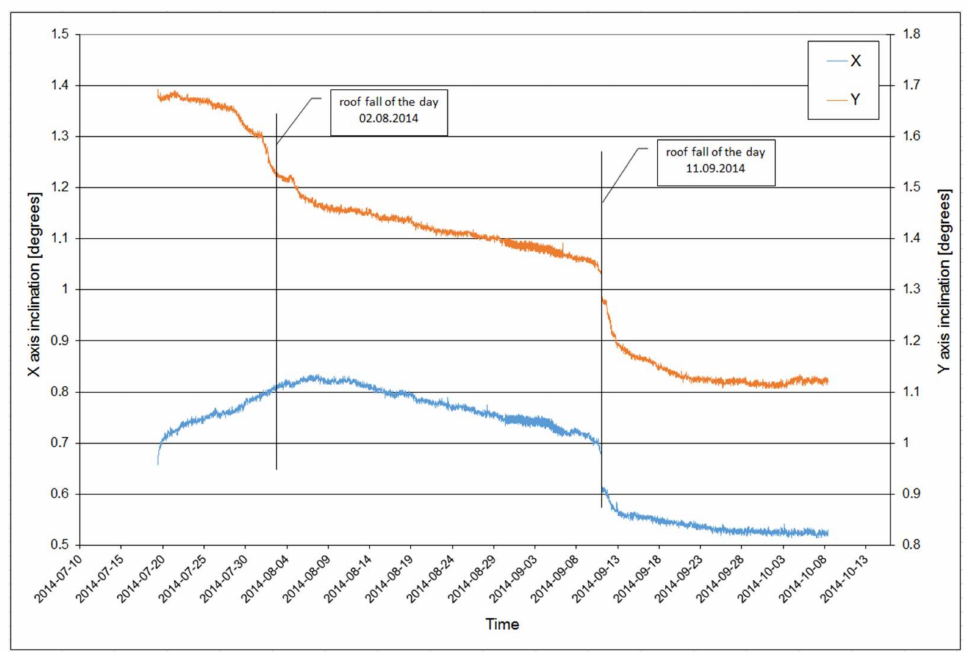
Figure 21. Changes in the inclination (X and Y components) recorded at station 1.3 located in the